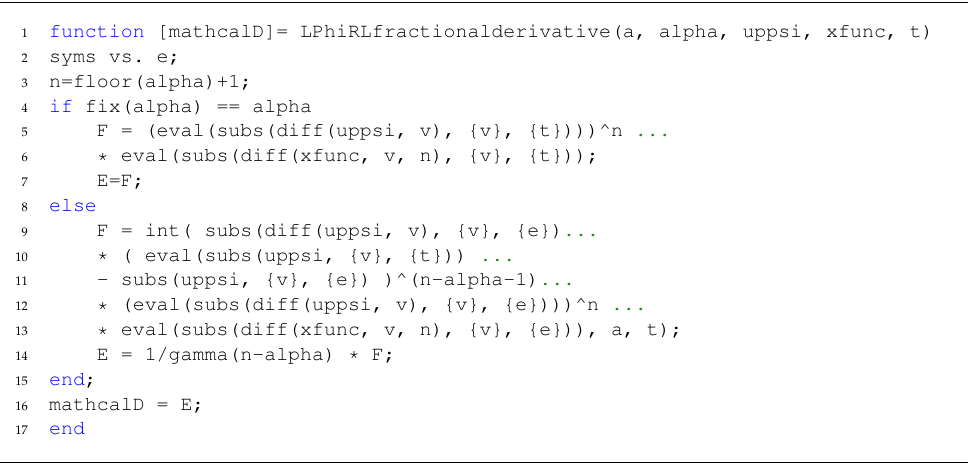
Algorithm 2: MATLAB lines for getting q th G -Caputo derivative of function v